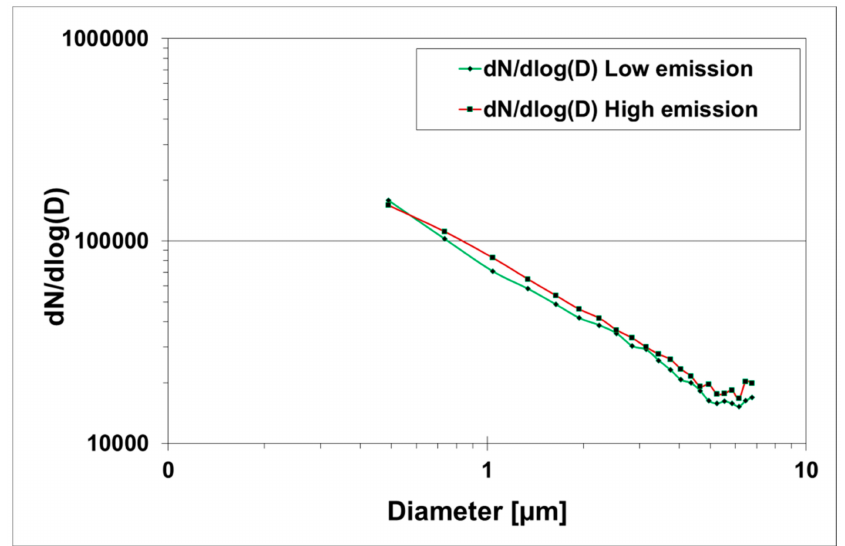
Figure 4. Size distribution of fluorescent particles in the samples analysed for fluorescence spectra under low and high emission